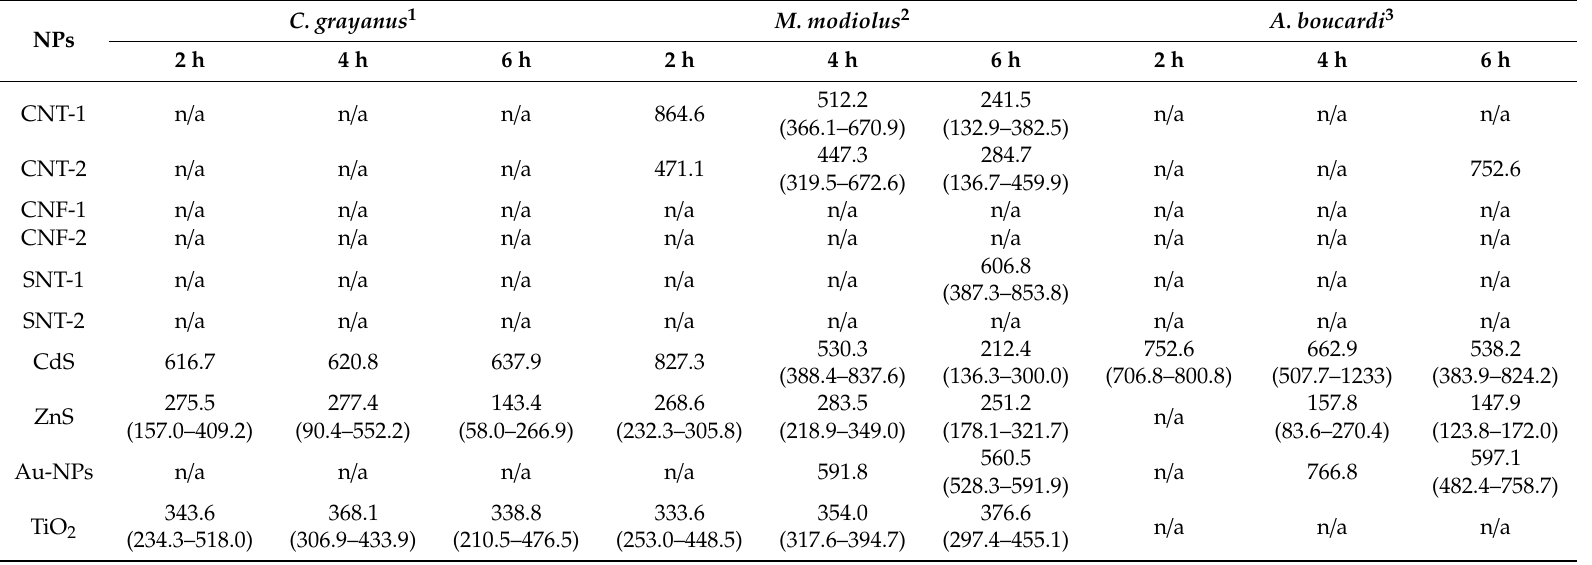
Table A1. Calculated values of EC 50 for viability of the hemocytes after the exposure to the nanoparticles, mg /